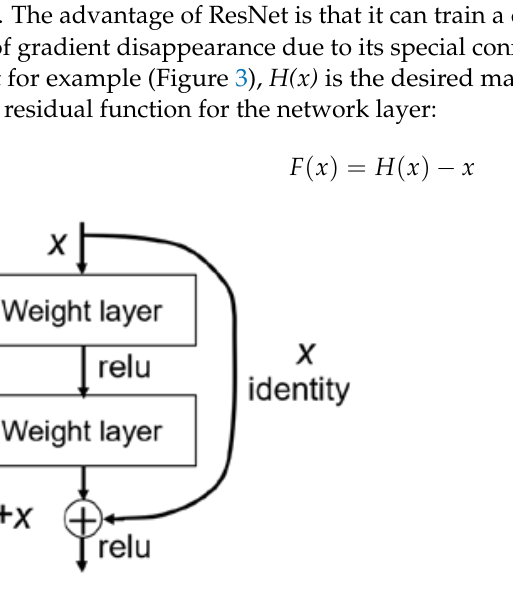
Figure 3. The building block of